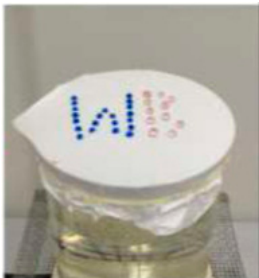
Figure 7. Waterproof and breathability investigation of an electrospun PAN-modified PDMS membrane. The electrospun PAN modified PDMS membrane is made to cover the beaker with water. Due to the hydrophobicity of the membrane, the water droplets placed on the membrane are restricted from entering the membrane. On the other hand, when the setup is heated, the membrane is permeable to water vapor. Thus, when silica gel is placed on the membrane, it changes its color from blue to pink. Reprinted with permission from Junlu Sheng, Min Zhang, Yue Xu, Jianyong Yu, Bin Ding, Tailoring water-resistant and breathable performance of polyacrylonitrile nanofibrous membranes modified by polydimethylsiloxane, ACS Applied Materials and Interfaces 2016 , Vol. 8, 27218–27226. Copyright (2016), American Chemical Society.